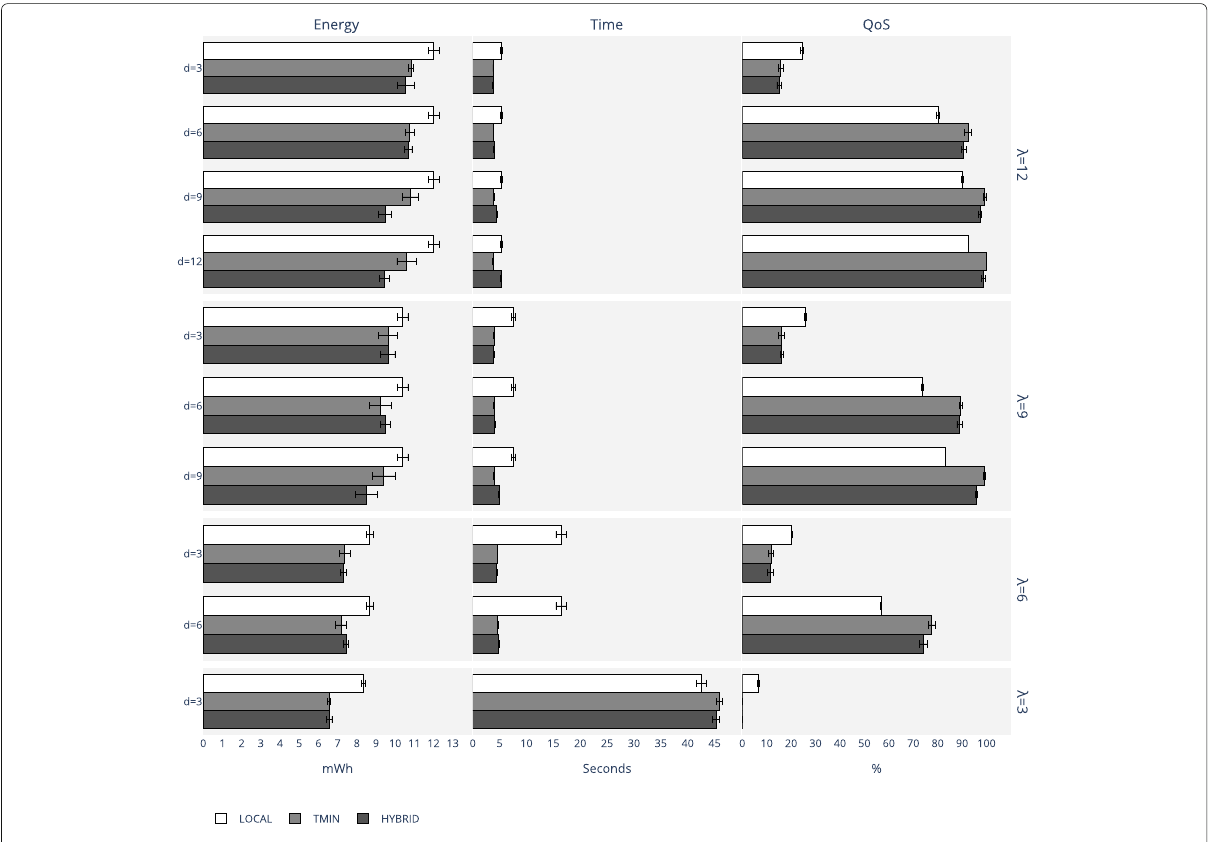
Fig. 7 Android devices scenario – energy, time, and